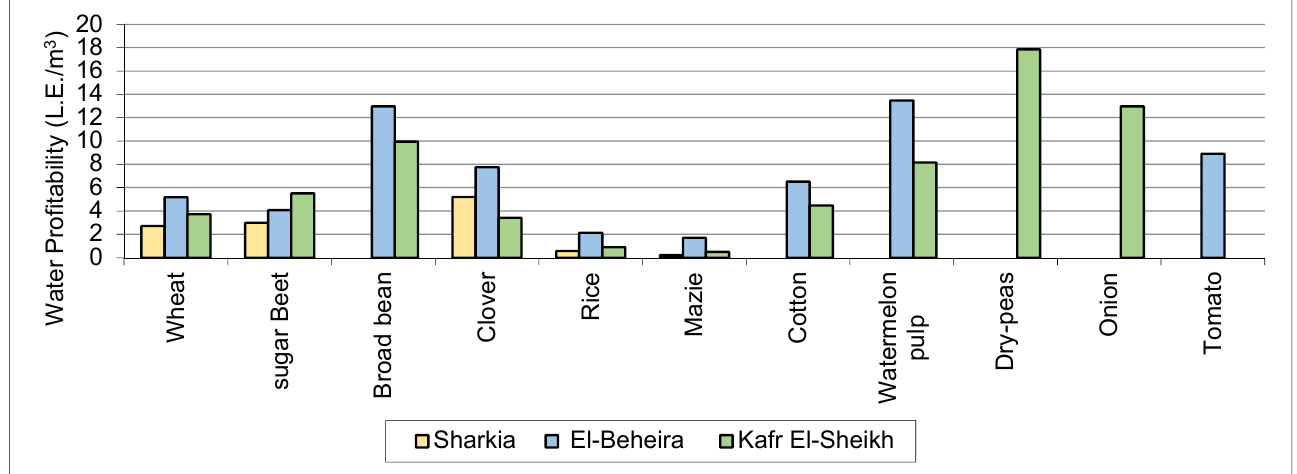
Figure 5. Cross-governorate water profitability comparison for 2020, source: field data collected from farmers and verified by workshops.